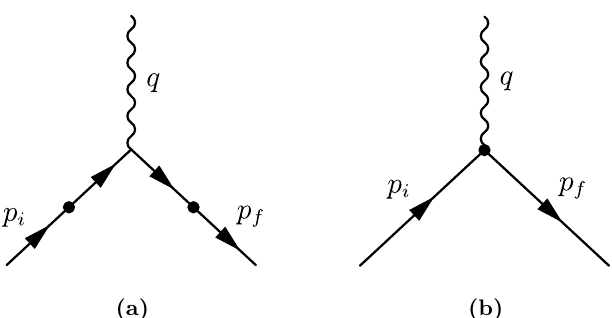
Figure 1 . Contributions responsible for a ‘ = ( g − 2) ‘ / 2 based on eq. (2.1). We use the conventions p i = ( P + q ) / 2 and p f = ( P − q ) / 2 for the coming and outgoing fermion momentum, respectively, and q ≡ p i − p f is the outgoing-photon momentum. The bullets indicate LV insertions, i.e. the modification of the propagation of the charged lepton and the coupling to the photon,